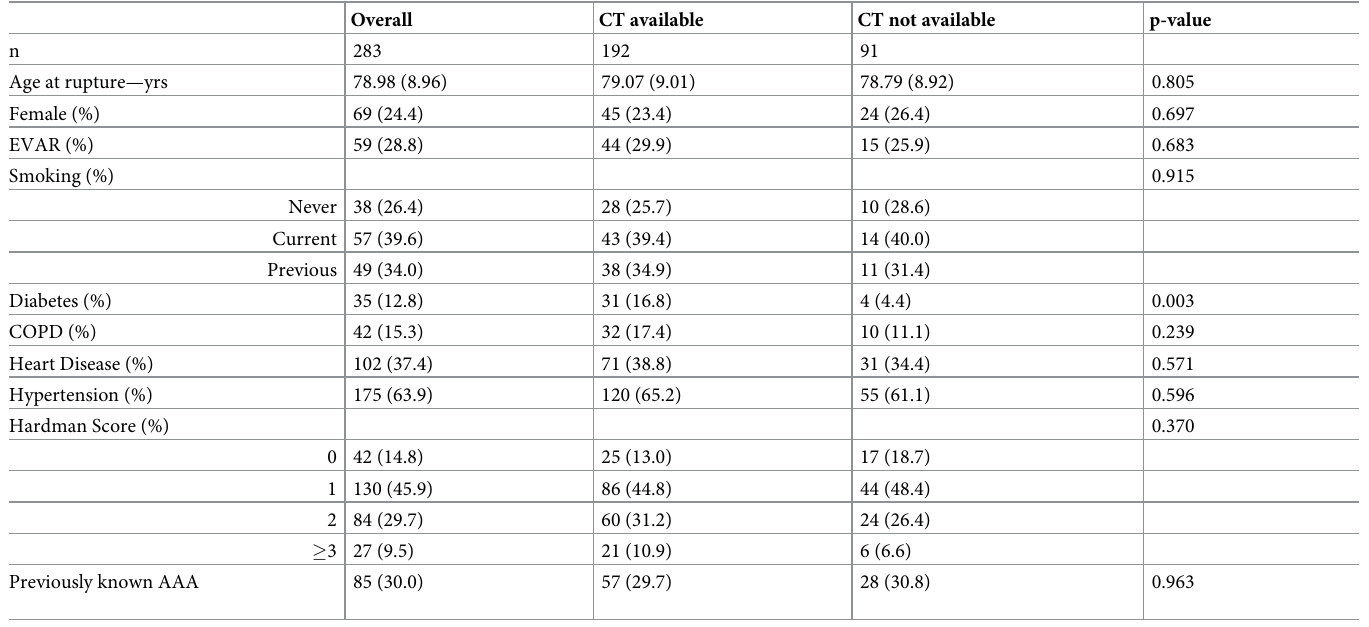
Table 1. Basic characteristics for patients with ruptured abdominal aortic aneurysm where CT imaging was available vs no CT imaging available. Overall CT available CT not available